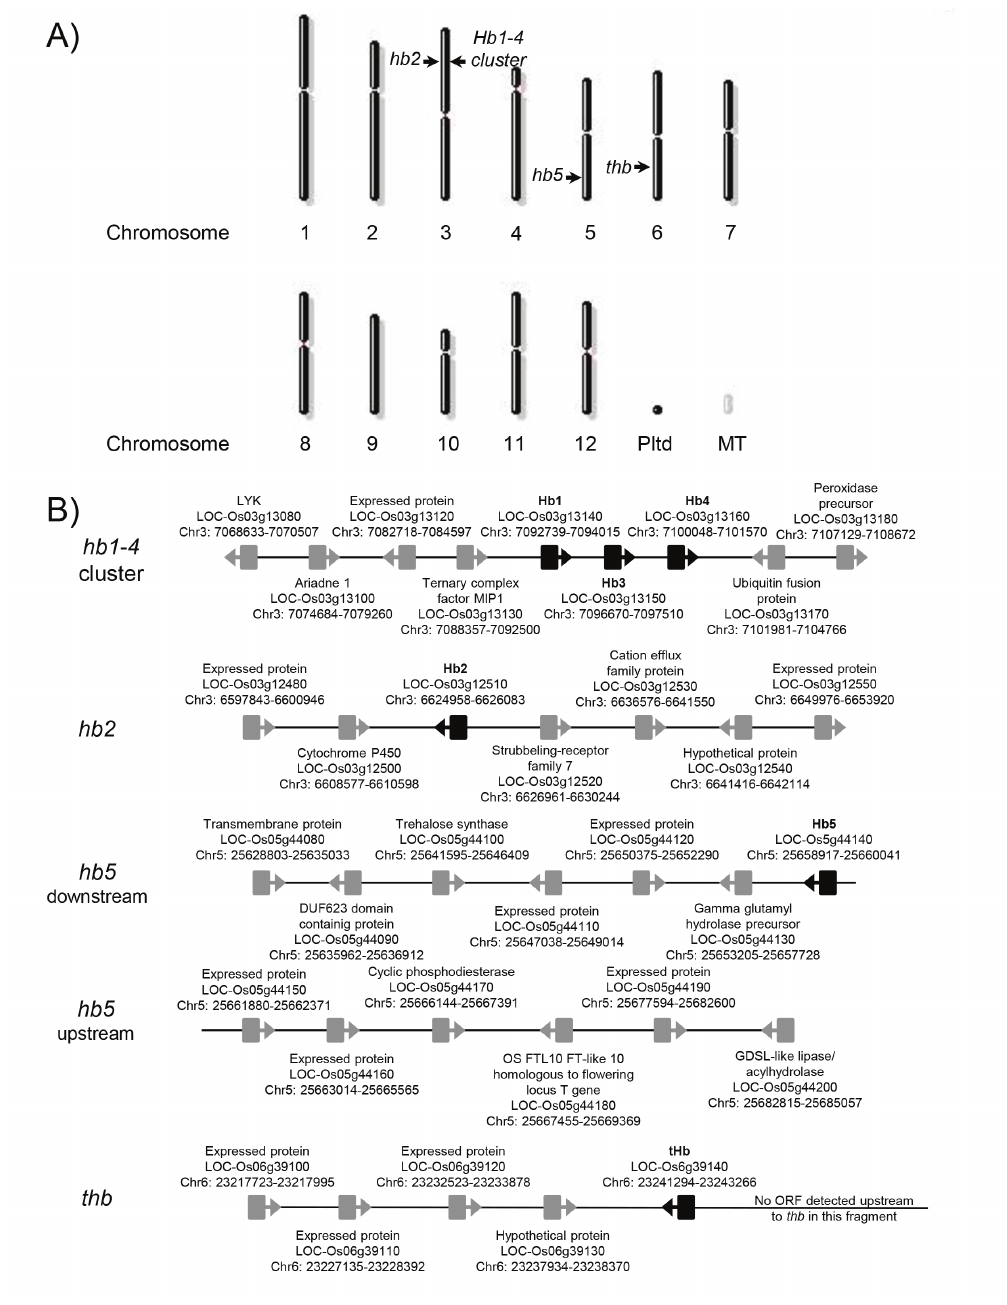
Figure 2. Localization of hbs in the O. sativa chromosomes (A) and mapping of hb genes into the O. sativa genome (B). The hb genes were localized in the rice chromosomes by BlastN analysis using the rice ( O . sativa ) genome resource from the GenBank database as template and the sequence for the rice hb1 , hb3 and hb4 (GenBank accession number AF335504), hb2 and hb5 (GenBank accession numbers AF335503 and EF061459, respectively) and thb (GenBank accession number NM_001064507) genes as probes. The hb (black boxes) and flanking (gray boxes) genes were mapped into 50 kb fragments of the O . sativa genome by BlastN2.2.26+ analysis using the Phytozome V9.1 server (www.phytozome.org) and the above hb sequences as probes. Arrows indicate the transcription orientation. Information for each gene corresponds to predicted protein (following the Phytozome nomenclature), locus name in the O . sativa genome and position at the O . sativa chromosome. Gene sizes and distance between genes are not shown at scale. Pltd, chloroplast chromosome; MT, mitochondrial